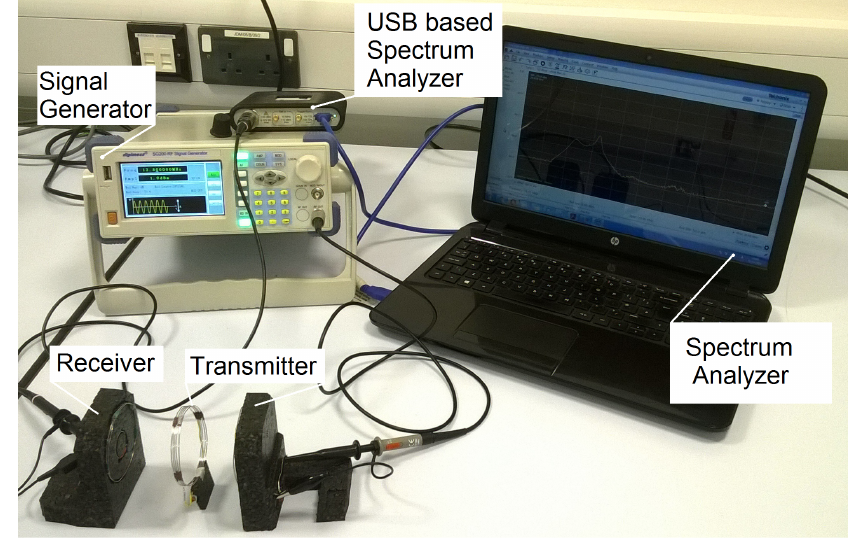
Figure 6. Practical implementation of the combined CSMR-SCSMR